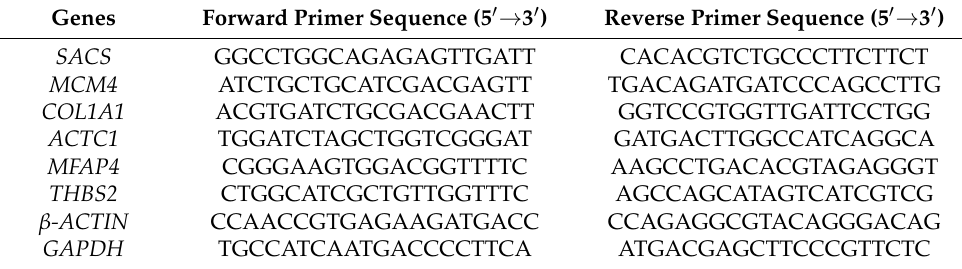
Table 1. Primer sequence for real-time quantitative PCR.